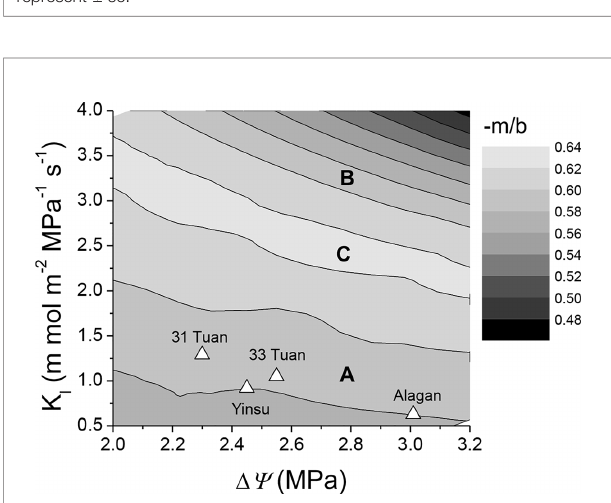
FIGURE 6 | Semi-contour plots of − m/b as dependent on D Y and K l . Plots are derived from the hydraulic model (Equation 1). The simulated − m/b at the four studied sites are shown as ( D ). A and B in the fi gure represent belts with same − m/b but different K l at noon, C represents belt with higher − m/b than A and B , but its K l at noon is between those of A and B . Note the unit of K l is mmol m − 2 MPa − 1 s − 1 .